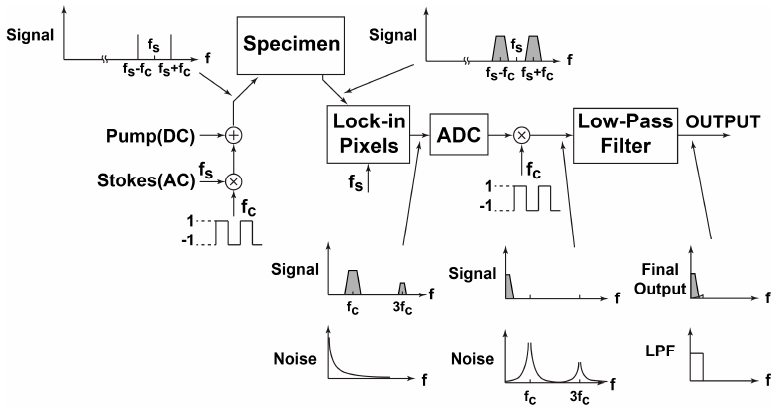
Figure 11. Double modulation technique to reduce low-frequency noise component and residual offset component.